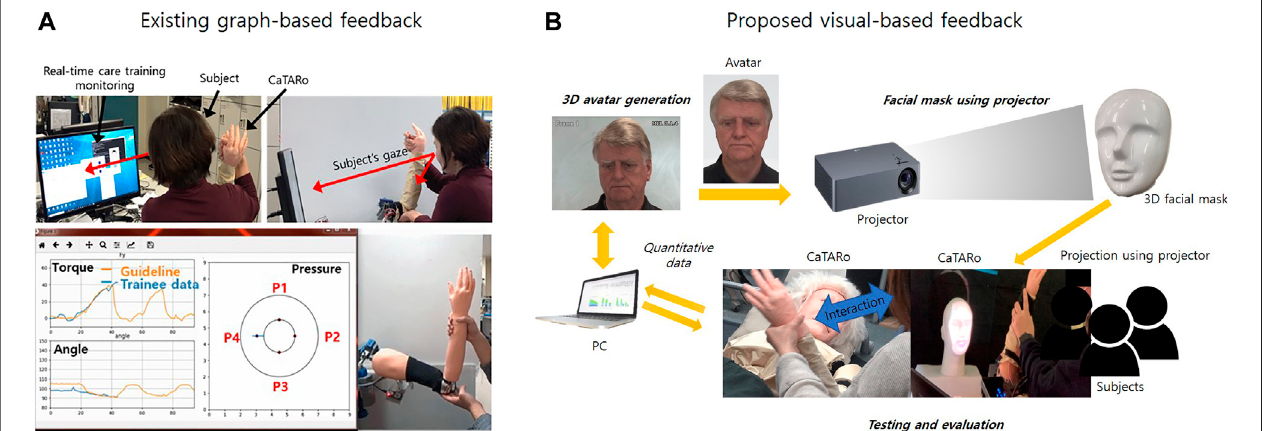
FIGURE 1 | The proposed care training system with visual-based